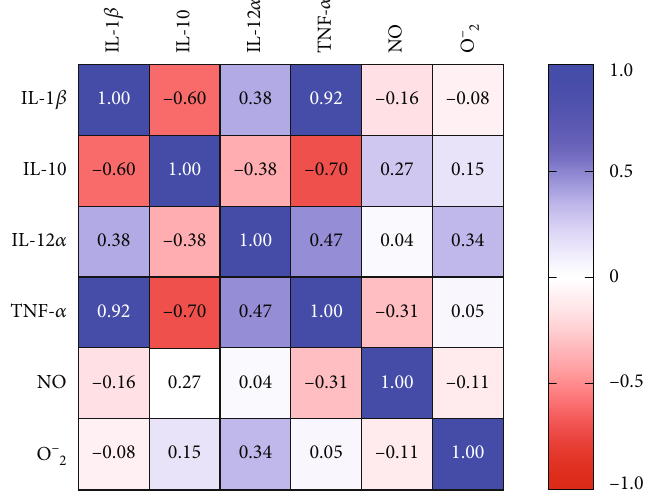
Figure 4: Spearman correlation coe ffi cients between di ff erent markers of macrophage